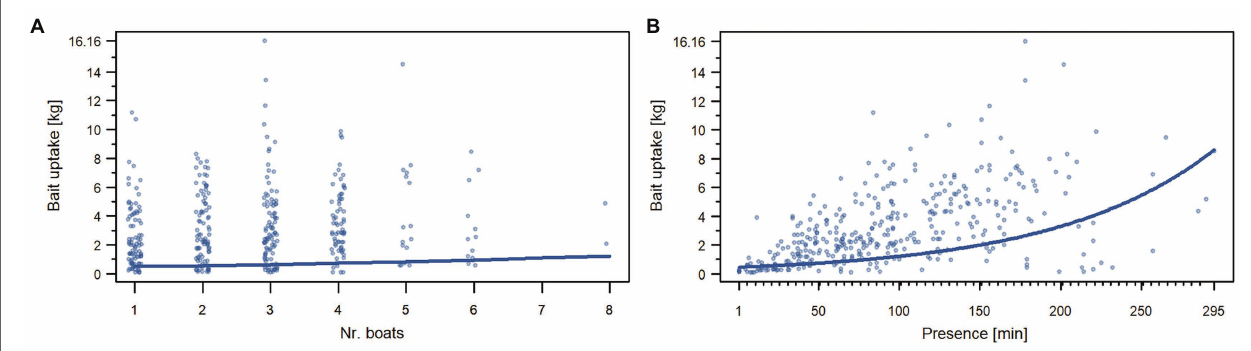
FIGURE 4 | Effects of the number of boats (A) and the presence time (B) on the bait uptake of great hammerhead sharks ( S. mokarran ) during provisioning dives. Plots (A) and (B) show the Poisson part of model 4. The x -axis contains the predictor variables, and the y -axis contains the response variable. The y -axis has been transformed to show the bait uptake in kilograms. For the ease of representation, only bait uptake values >0 kg have been included in these plots. Colored curves represent significant regressions extracted from model 4 ( Table 5 ). The plots that contain a graphical representation of the non-significant effects for model 4 can be found in Supplementary Figure 3